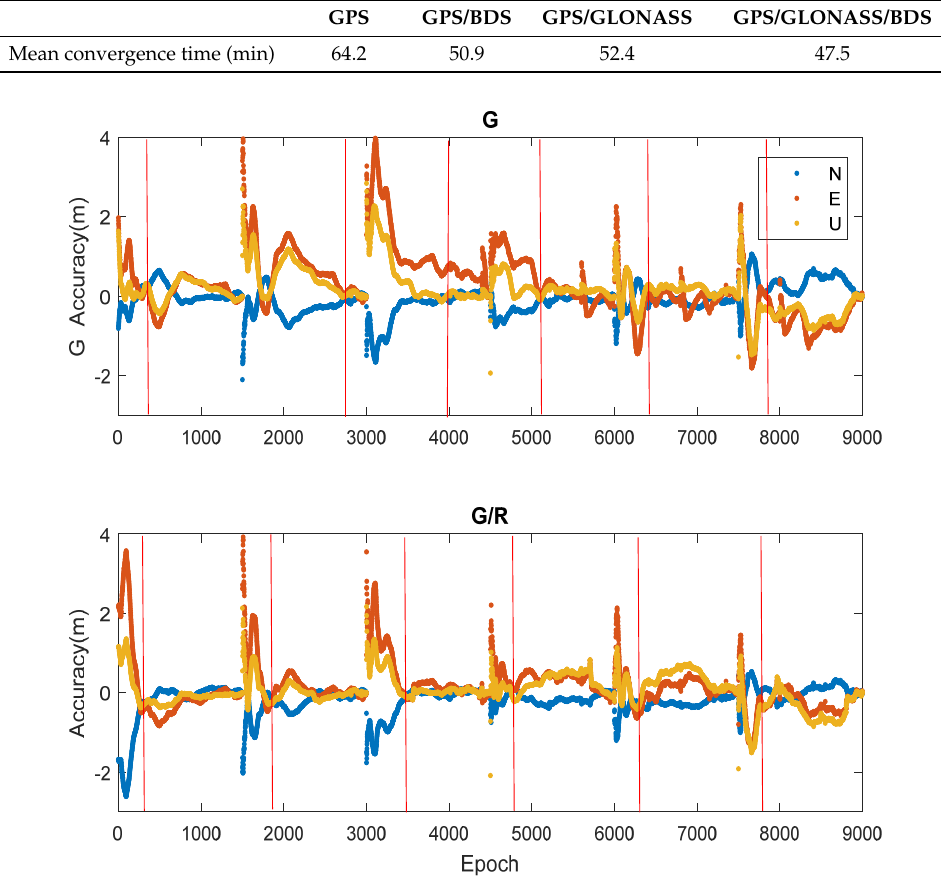
Figure 5. The difference between the PPP kinematic and RTK solutions (GPS and GPS/GLONASS).